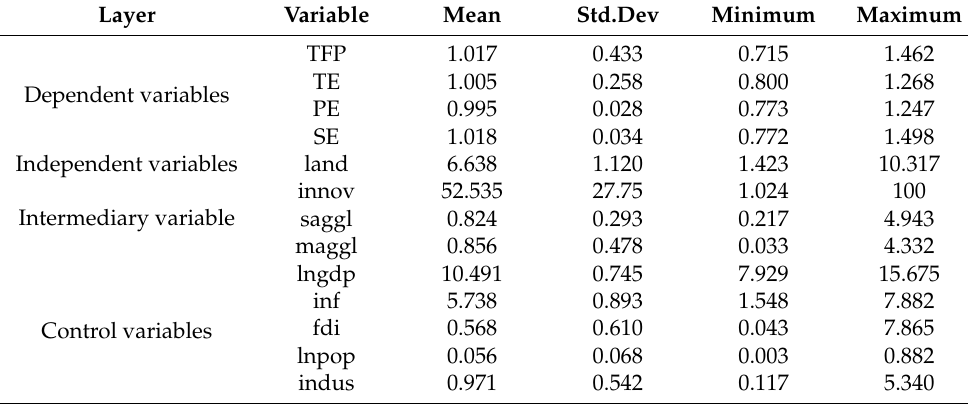
Table 2. Descriptive statistics of